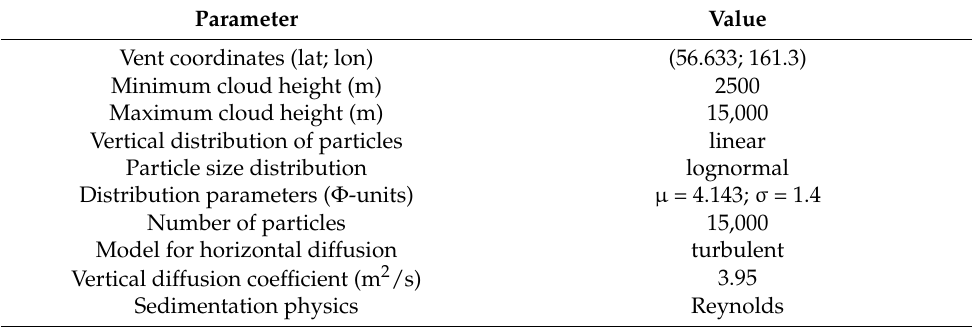
Table 4. PUFF model